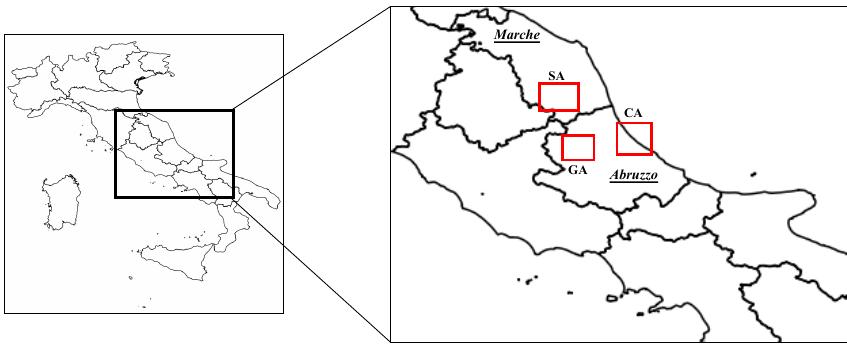
Figure 2. Location of the three specific areas with significant rainfall in 24h, Gran Sasso area (GA), Monti Sibillini area (SA) and Central- Northern Abruzzo coast (CA)